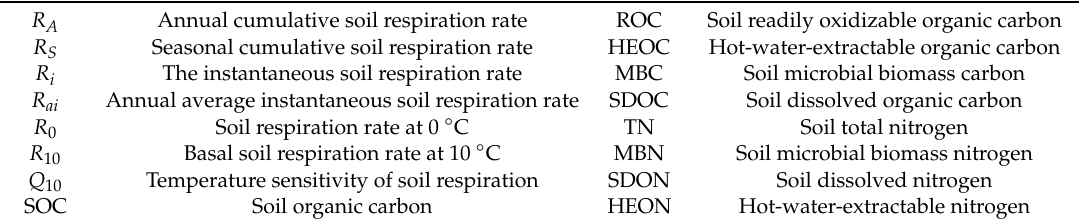
Table 2. List of